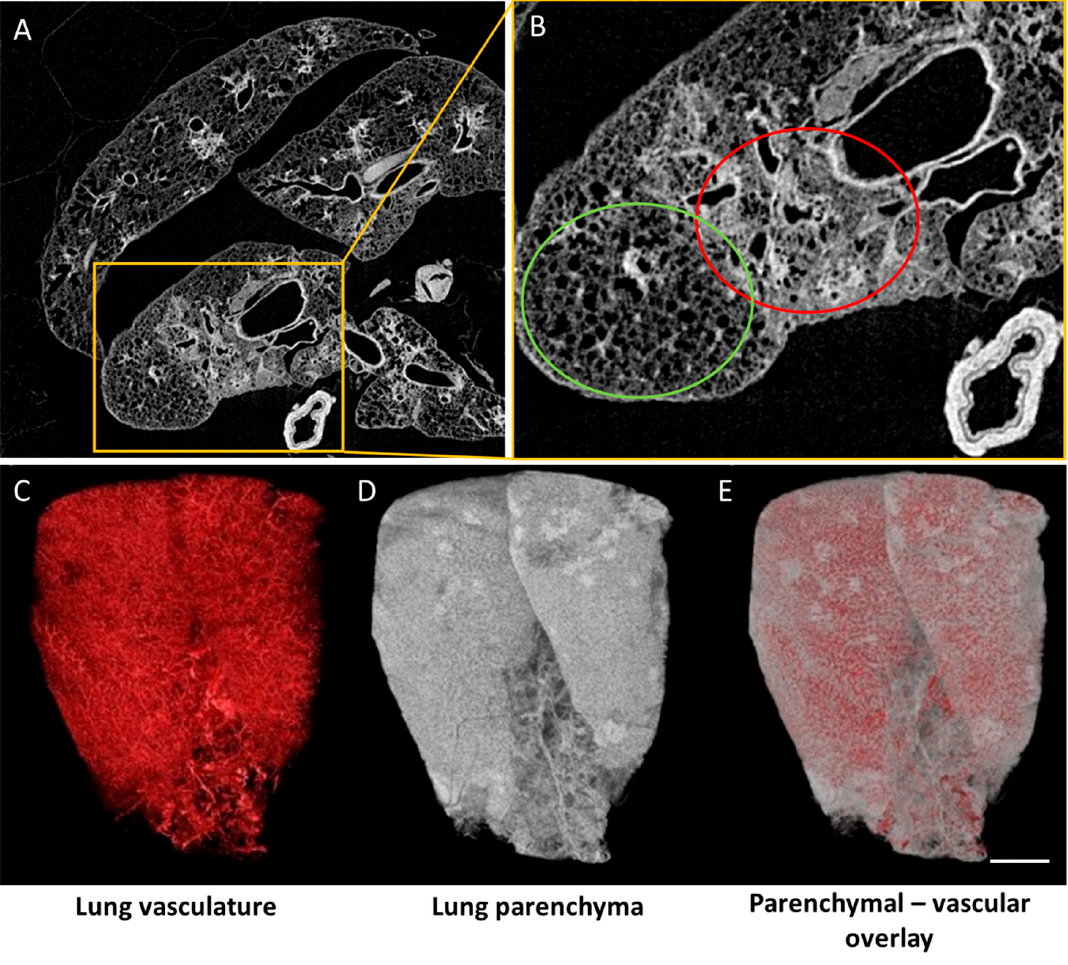
Figure 4. High resolution ex vivo µ CT of isolated rodent lung. ( A ) Reconstructed µ CT of whole mouse lung, visualizing spatial di ff erences in lung pathology; ( B ) enlargement of the yellow box in A, zooming in on spatial di ff erences in areas with localized lung inflammation (red circle) and non-pathological regions (green circle); ( C – E ) Ex vivo µ CT of rat lung with barium-based vascular perfusion. Vascular network rendered with maximum intensity projection (MIP) ( C ); lung parenchyma visualized using minimum intensity projection (MinIP) ( D ); an overlay of parenchymal and vascular tissue ( E ). Scale bar 5 mm. Video is available as Supplementary Video S2.